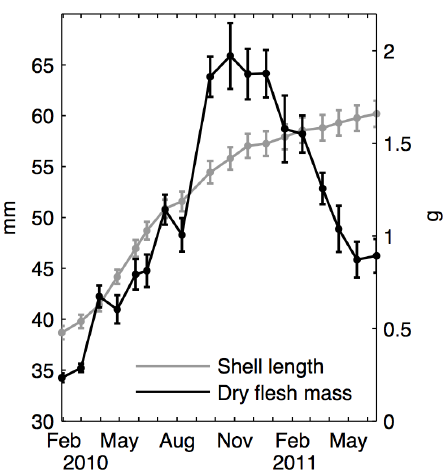
Figure 2. Observed mussel growth during the experiment. Shell length (grey) and dry flesh mass (DFM) (black) mean values and deviations correspond to monitoring with sacrifices, corrected for sampling